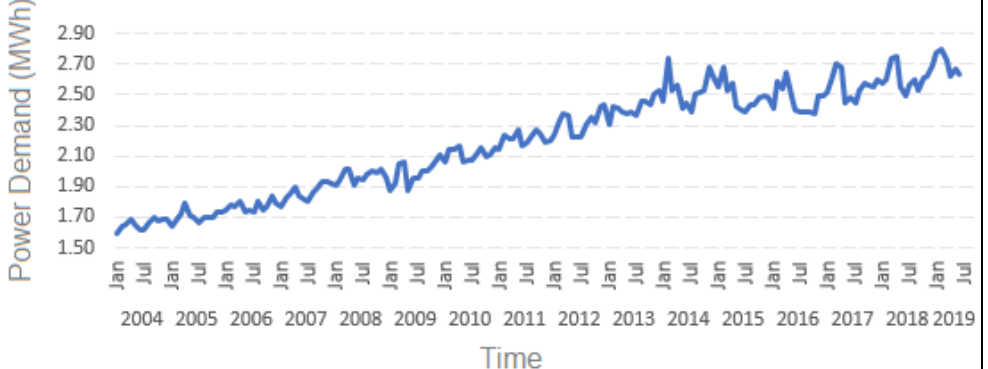
Figure 1. Paraná state energy consumption data for the period from January 2004 to June 2019. Figure 1. Paran á state energy consumption data for the period from January 2004 to June Table 4. Non-parametric tests for trend and seasonality analysis .